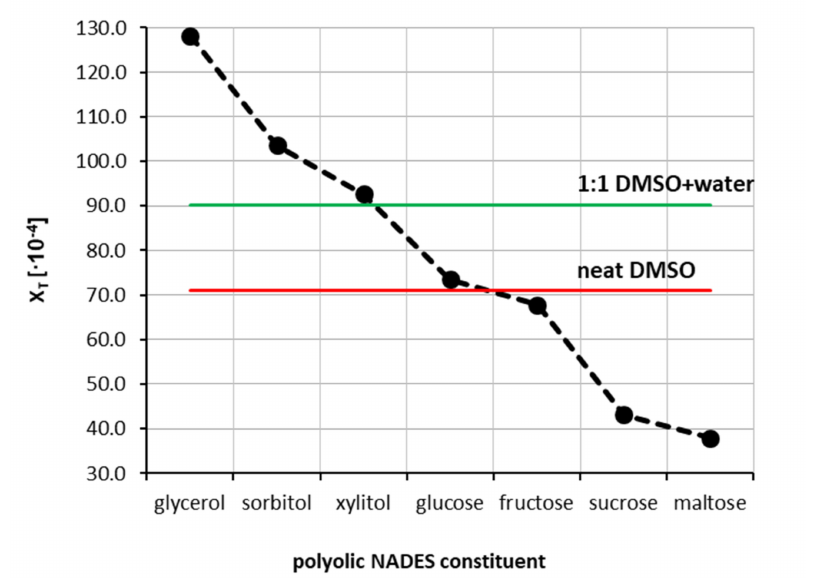
Figure 3. Mole fraction solubility of theophylline determined in water-free natural deep eutectic solvents at 25 ◦ C. All designed solvents were prepared in unimolar proportions.